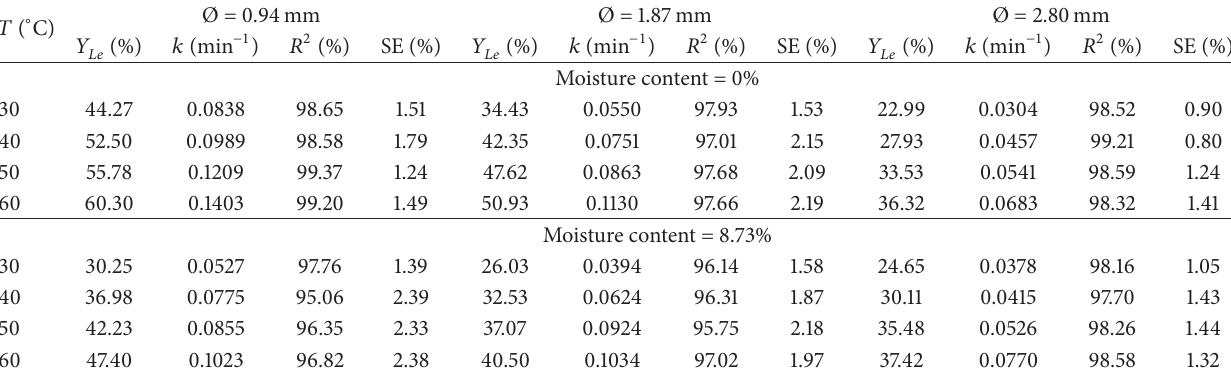
Table 2: Equilibrium ( 𝑌 𝐿𝑒 ) and mass transfer coefficient ( 𝑘 ) parameters obtained for the extraction kinetics of Jatropha oil with moisture contents of 0 and 8.73% at different temperatures with varying particle sizes.